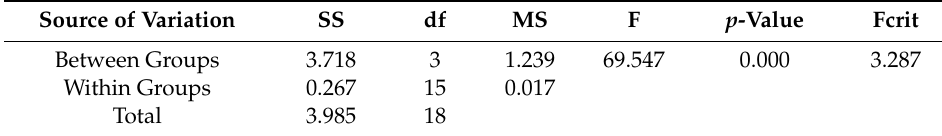
Table 5. ANOVA of extension at break and b. post hoc